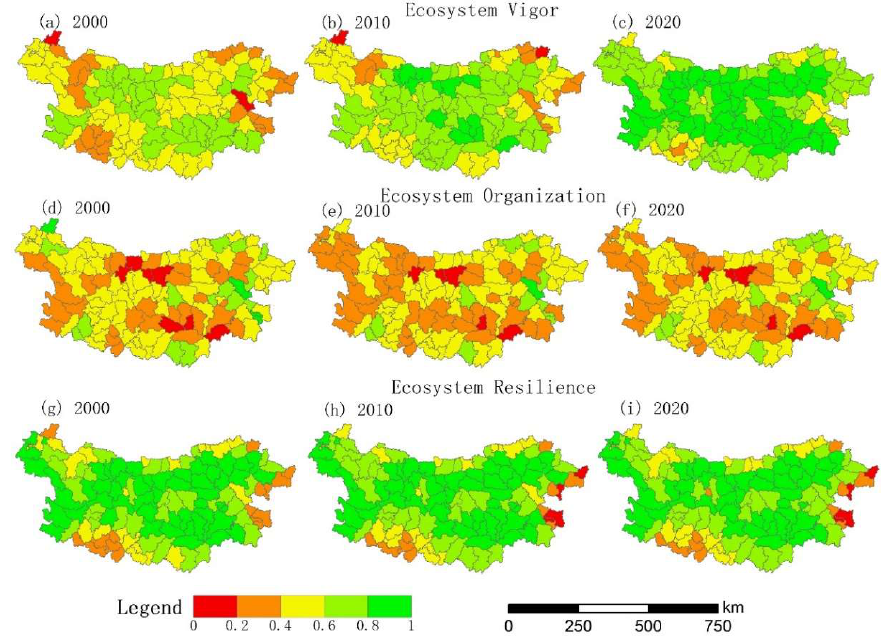
Figure 3. Changes in ecosystem indicators for each county in the Qinling-Daba Mountains from 2000 to 2020. ( a – c ) Ecosystem vigor for each county ( d – f ) Ecosystem organization for each county ( g – i ) Ecosystem resilience for each county.